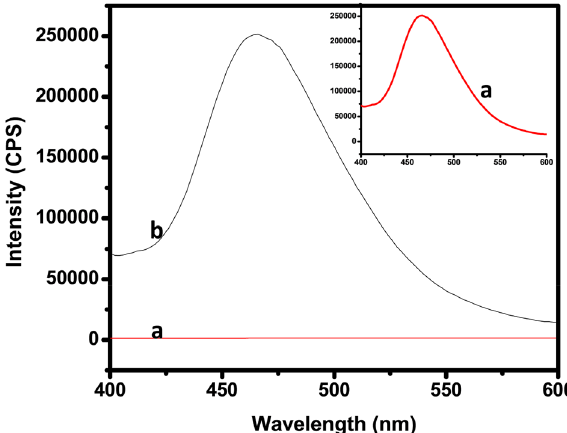
Figure 9. PL spectra of ( a ) TANI/Cu 2 O/Ag NC and ( b ) pure TANI.